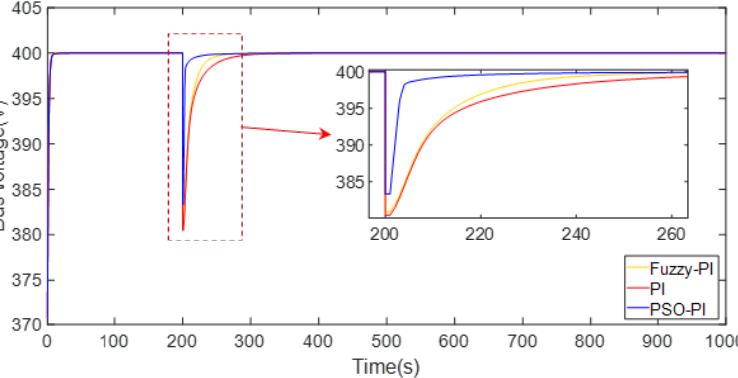
Figure 33. DC bus voltage when one generator fails.